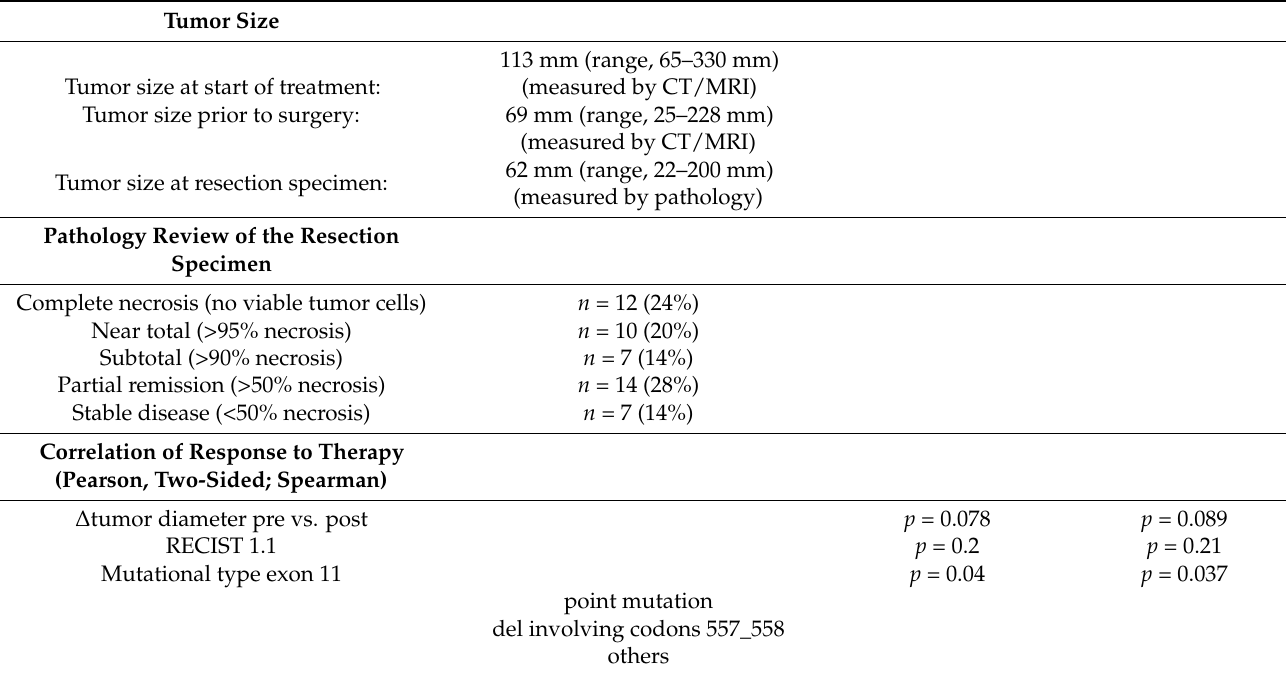
Table 1. Analysis of Response